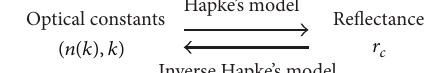
Figure 2: Hapke’s model, reflectance can be calculated when optical constants/single scattering albedo are known.